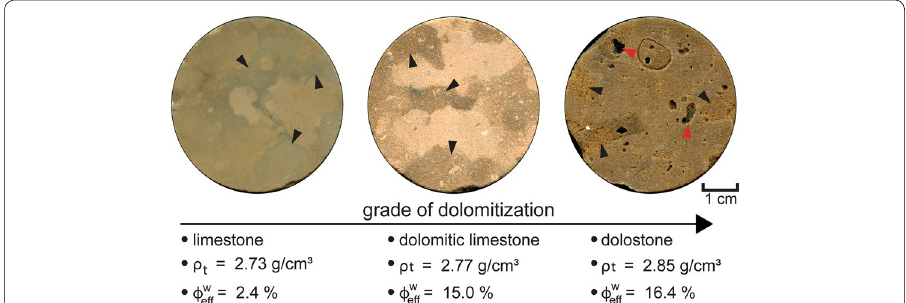
Fig. 6 Bioturbated wackestones showing different stages of dolomitization. Porosity increases with grade of dolomitization. Note bioturbation and burrows (black arrows) that are progressively substituted by sucrose dolomite rhombs. Location of the right sample is only 30 cm deeper than the middle one, but shows complete dolomitization with abundant intercrystal porosity and moldic porosity (red arrows). Left: DGF-FB, 246 mTVD, middle: MSC-4, 1138.9 mTVD, right: MSC-4 1139.2,